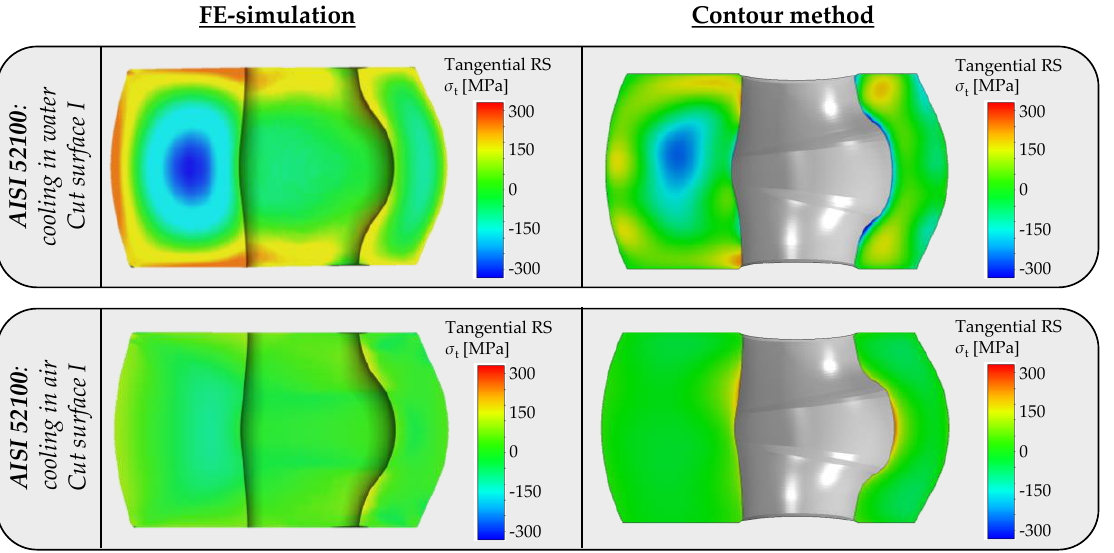
Figure 12. Comparison of the spatial distribution of tangential RS on the cut surface of AISI 52100 after cooling in water or air from the FE-simulation and the contour method.